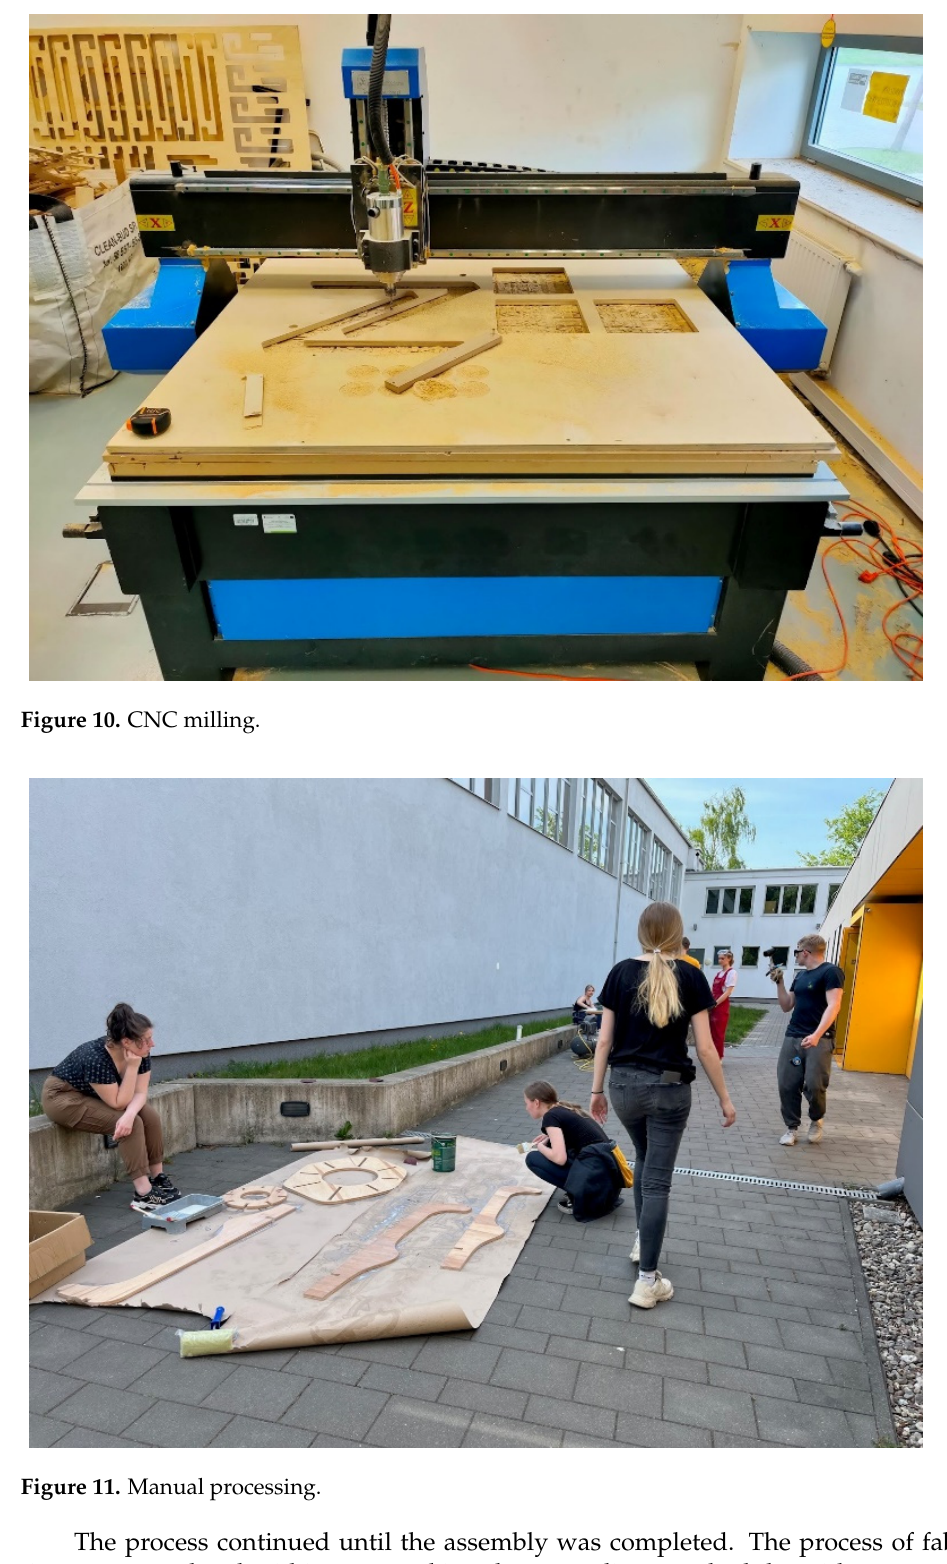
13 of 21 Figure 9. Tool path generation.